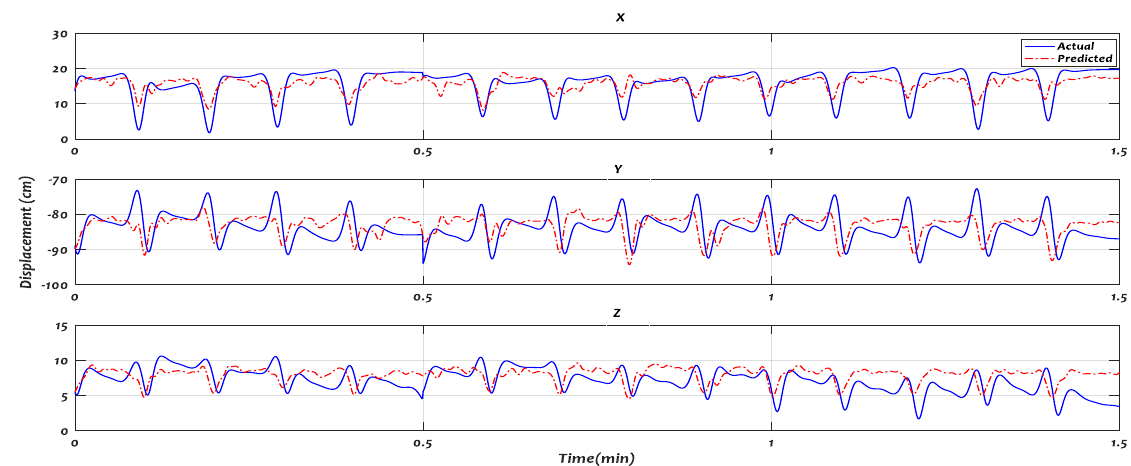
Figure 14. The trajectory predicted by recurrent fuzzy neural network (RFNN) against the actual trajectory of Task 1 in 3- D.